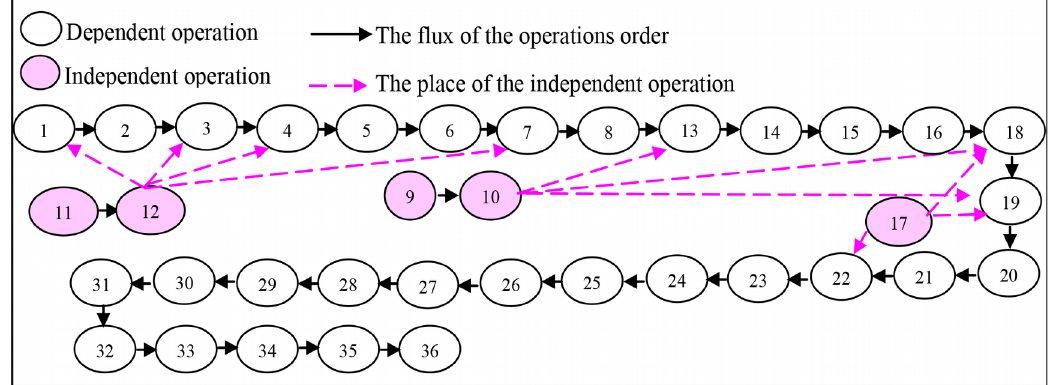
Figure 13. The precedence